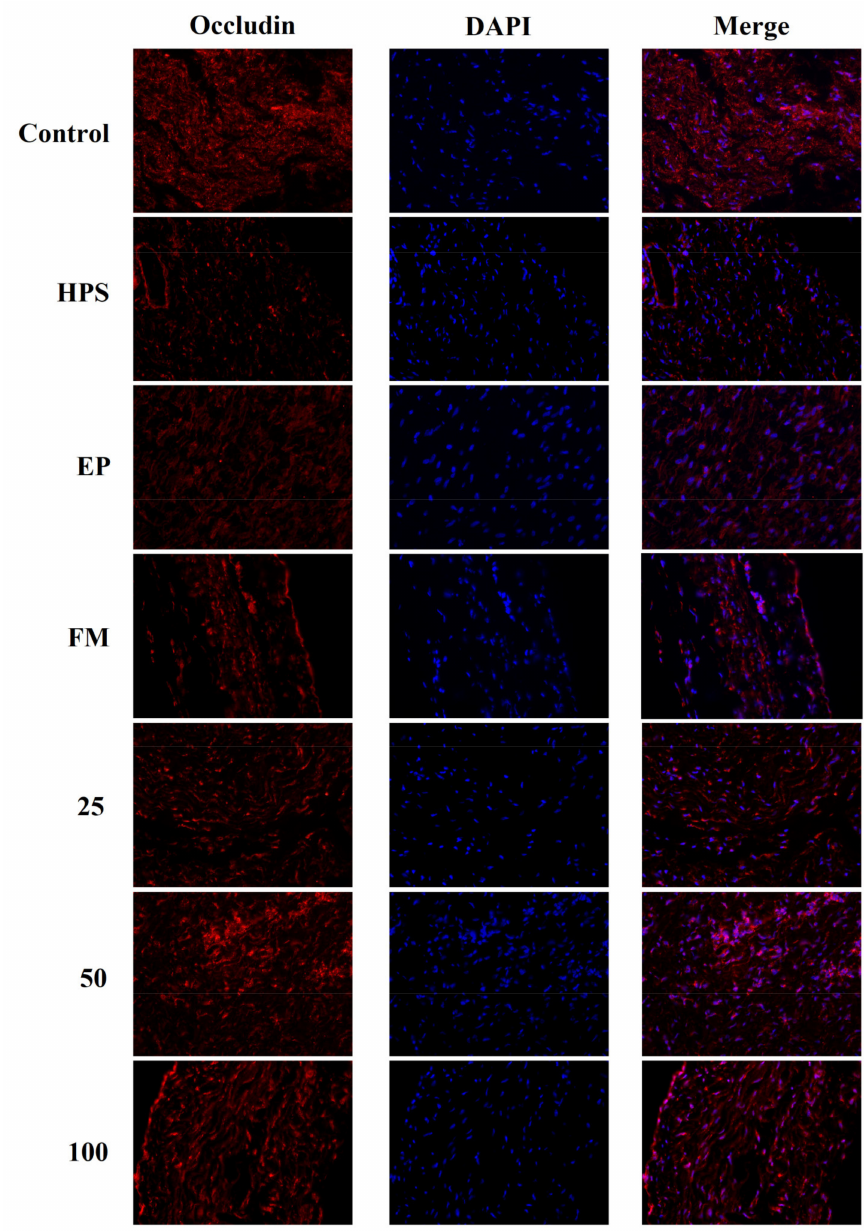
Figure 3. Effect of baicalin on the distribution patterns of Occludin in the peritoneum of piglets challenged with G. parasuis (magnification 10 × 40). HPS: G. parasuis group, EP:EP + G. parasuis group, FM:FM + G. parasuis group, 25:25 mg/kg baicalin + G. parasuis group, 50:50 mg/kg baicalin + G. parasuis group, 100:100 mg/kg baicalin + G. parasuis